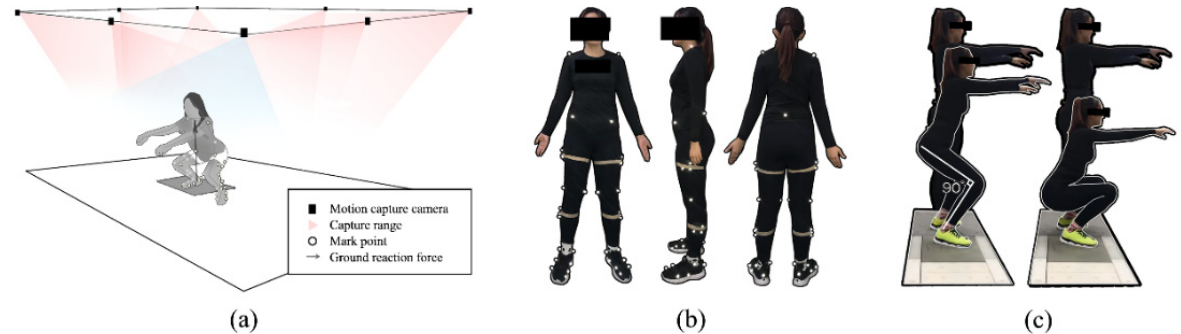
Figure 1. Experimental process, ( a ) Participant motion capture setup, ( b ) Illustration of each maker placement on the front, the right, the left, and the rear of the participants, ( c ) F-SQ and H-SQ practice.